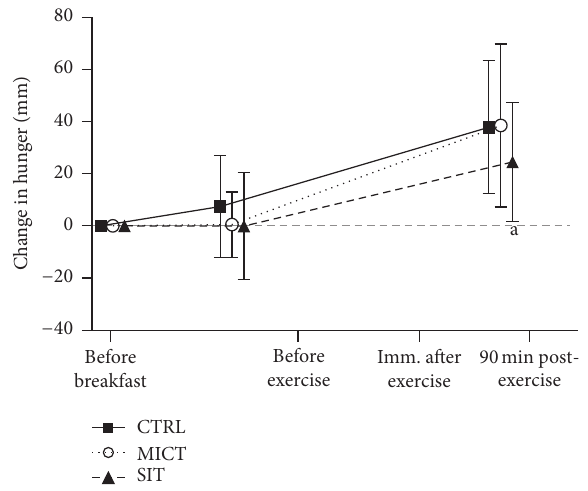
Figure4:Perceptionsofhungeratalltimepointsduringeachexper- imental session. CTRL: control (no exercise); MICT: moderate- intensity continuous training; SIT: sprint interval training. Note . a Significantly different versus CTRL and MICT ( 𝑝 < 0.027 ).